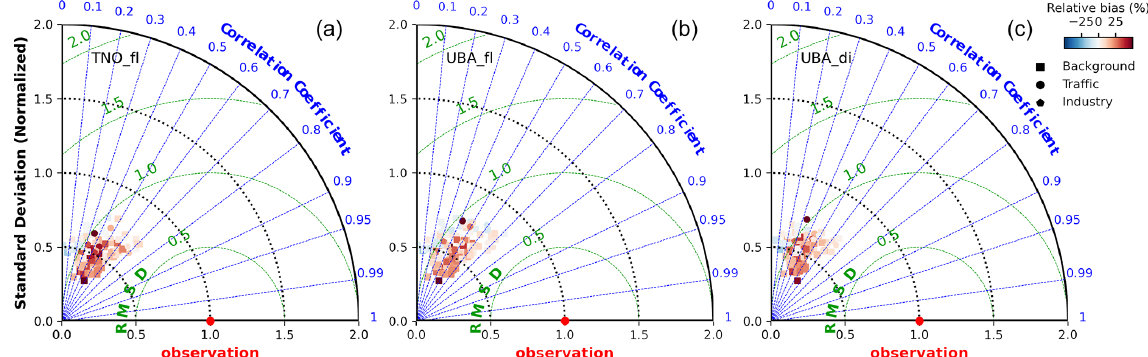
Figure B3. Taylor diagrams showing the Pearson correlation coefficients, normalized standard deviation and normalized root mean square difference corresponding to hourly-resolved measured and simulated O 3 VMRs (in CM02 domain) for background, traffic, and industrial sites represented as square, circle and pentagon markers, respectively. Panels (a) , (b) and (c) correspond to the TNO fl , UBA fl and UBA di set-ups, respectively.